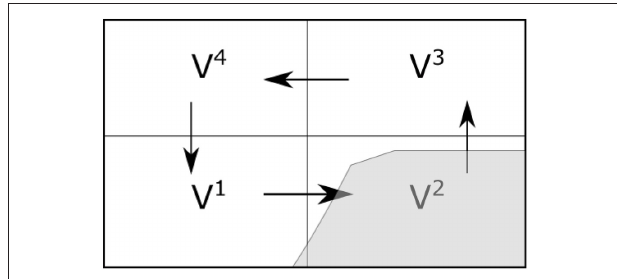
FIGURE 1 | Schematic of the three-dimensional valley-plain system indicating the four control volumes and the mean along-valley circulation during the up-valley wind phase. The arrows indicate the net mass flux across the interfaces between adjacent control volumes. See Figure 3 for a top view of the valley-plain